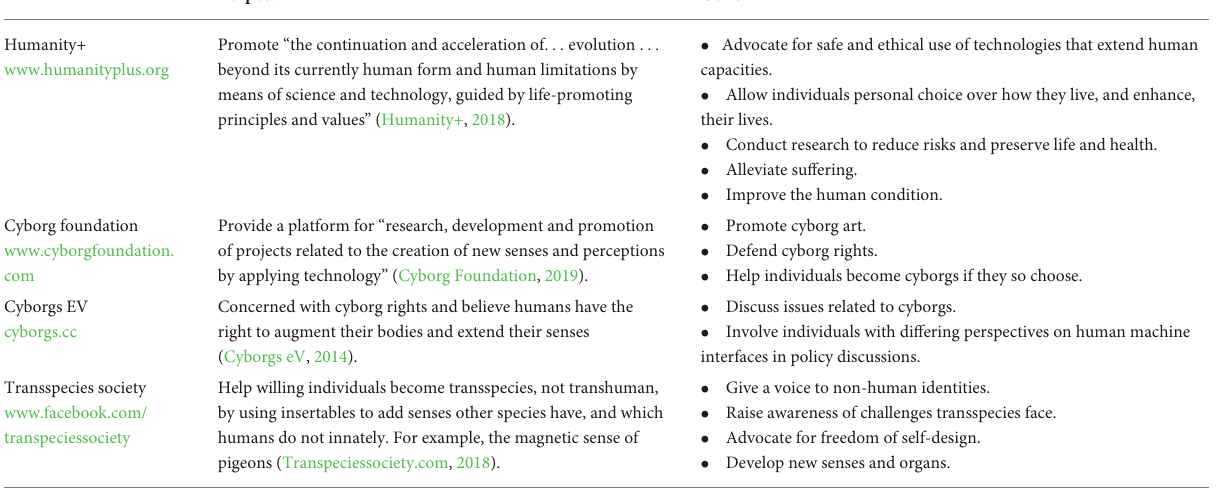
TABLE 2 Organizations supporting insertables